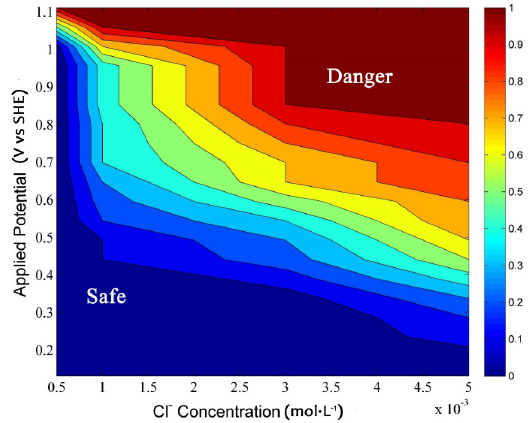
Figure 12. The top viewport of variation of the pitting probability with the potential and Cl − concentration at pH 11.5. The top view direction is on the axis of pitting probability, and the color scale indicates the value of the pitting probability.